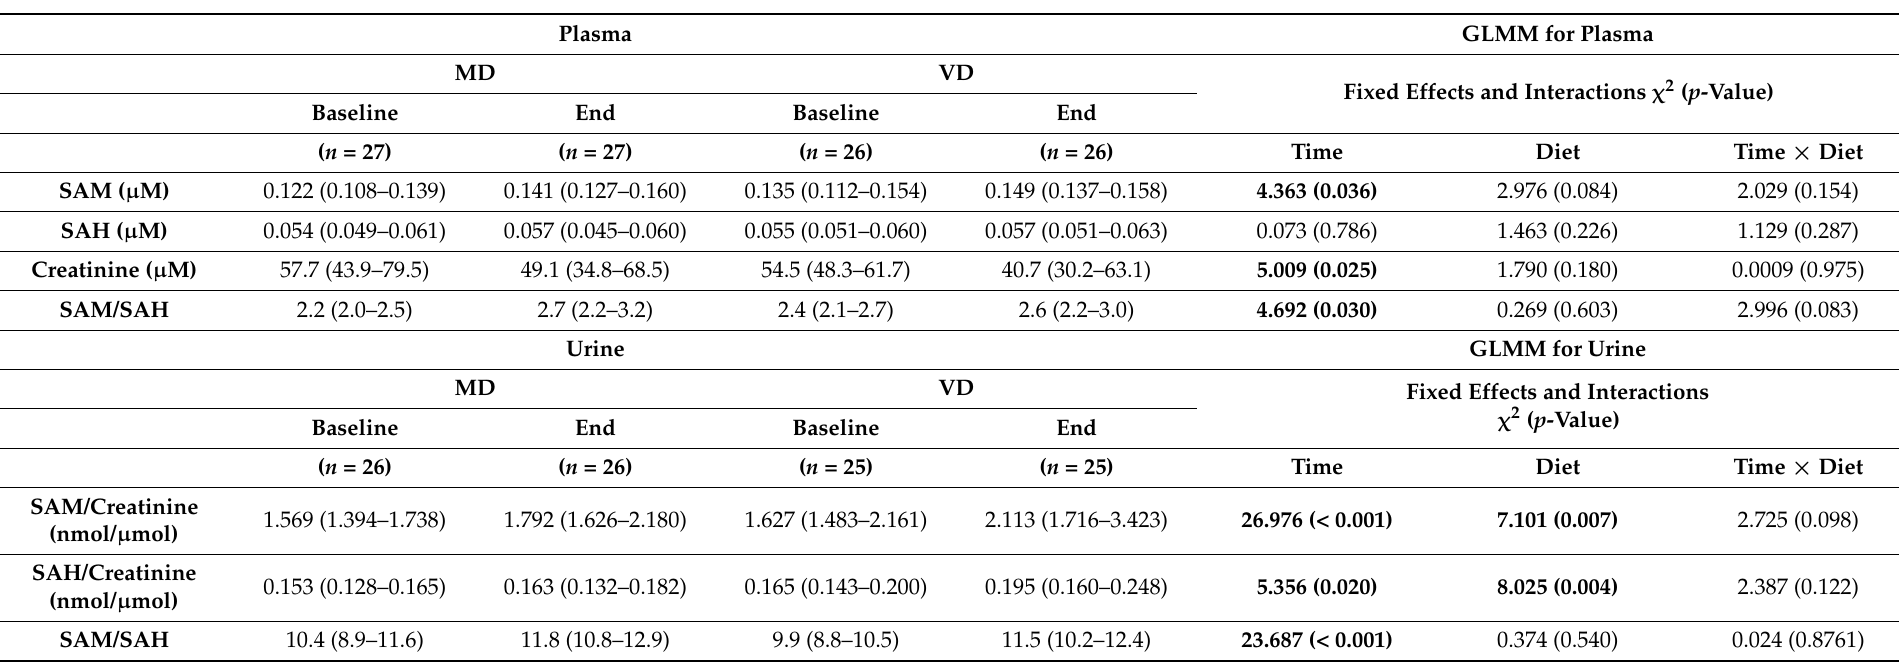
Table 6. Effect of dietary intervention on the concentrations of SAM and SAH in the plasma and urine of healthy subjects. Values are expressed as medians (1st quartile–3rd quartile) for descriptive statistics and χ 2 ( p -value) from a generalised linear mixed model (GLMM). p -values < 0.05 are highlighted in bold